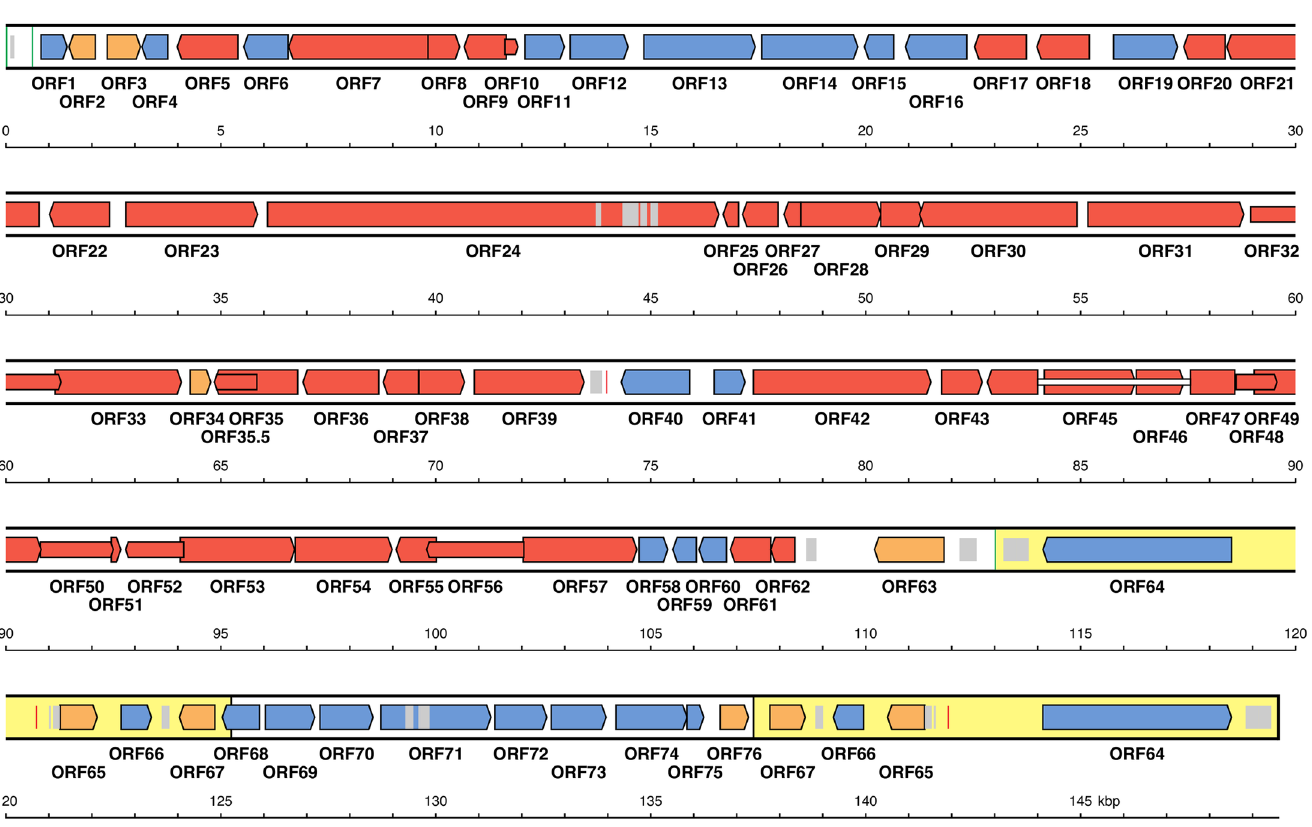
Fig 2. Map of the equid herpesvirus 8 (EHV-8) genome. The coordinates are based on the 149600 bp sequence of EHV-8/IR/2003/19. Predicted protein-coding regions are shown by coloured arrows with names below. Red open reading frames (ORFs) were inherited from the ancestor of family Herpesviridae and blue ORFs from the ancestor of subfamily Alphaherpesvirinae .Orange ORFs are specific to certain lineages within subfamily Alphaherpesvirinae . Inverted repeats TR S /IR S flanking U S are coloured yellow, and inverted repeats TR L /IR L flanking U L are shown by green vertical lines at 1–32 and 112999–113030 bp. A third green vertical line marks a third copy of the TR L /IR L sequence that is part of a more extensive inverted repeat at 1–87 and 547–633 bp. Tandem reiterations are marked by grey shading, and origins of DNA replication by vertical red lines.